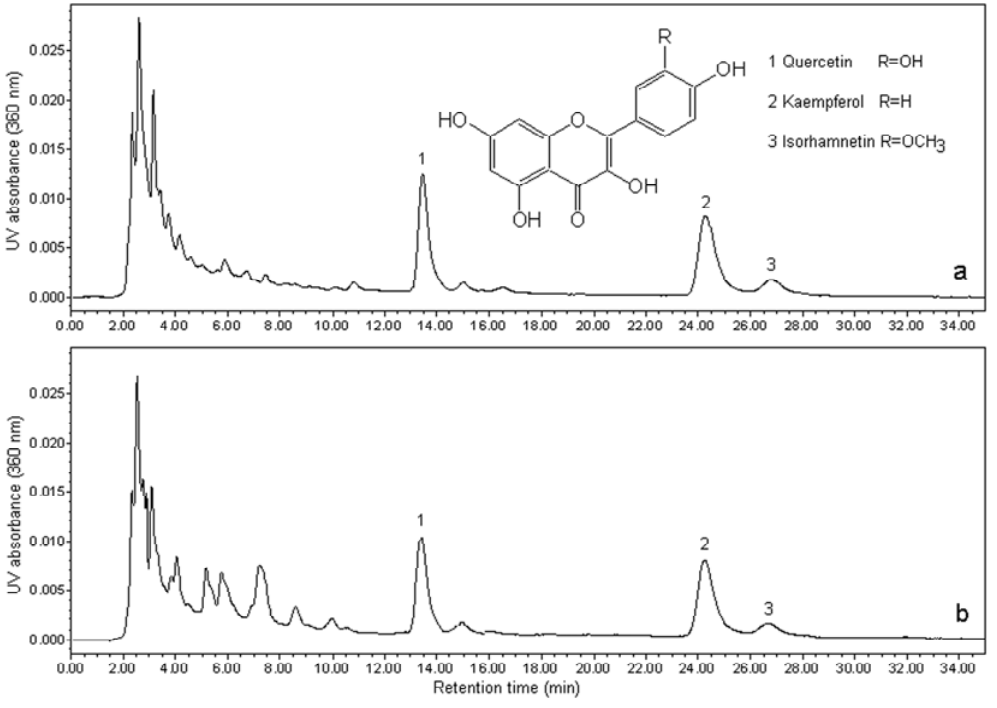
Figure 2. Comparative HPLC chromatograms for quercetin, kaempferol, and